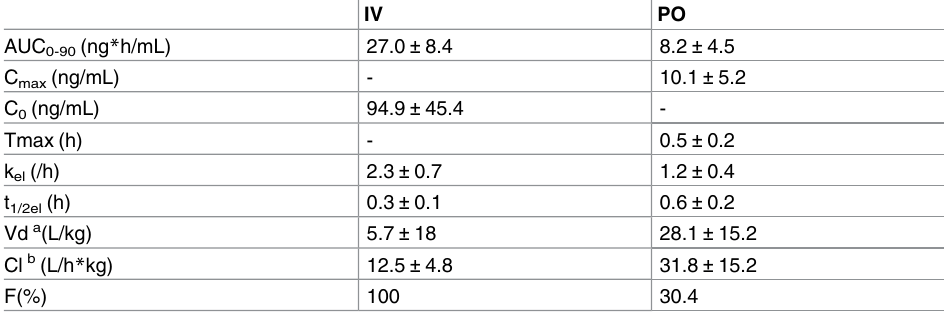
Table 2. Main toxicokinetic parameters (mean ± SD) of DON after single IV (n = 10) and PO (n = 6) bolus administration of 0.3 mg/kg BW to racing pigeons.